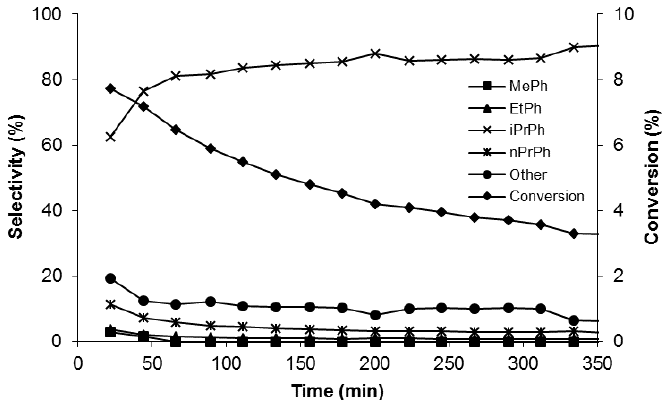
Figure 3. Time course for benzene alkylation by propane over 2% Pd/25% HSiW/SiO 2 (0.20 g catalyst, 300 °C, 1 bar pressure, inlet molar ratio C 6 H 6 /C 3 H 8 = 1:9, 10 mL min − 1 flow rate, W / F = 80 g h mol − 1 ; catalyst pre ‐ treatment at 300 °C/1 h in H 2 flow).